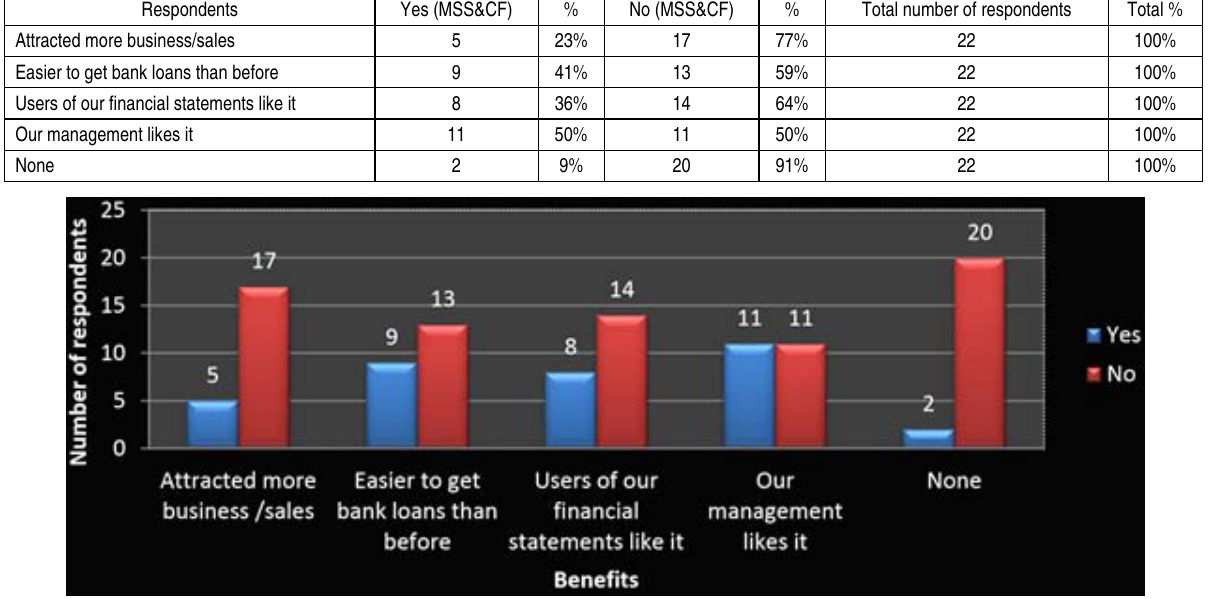
Fig. 5. Benefits of using IFRS for